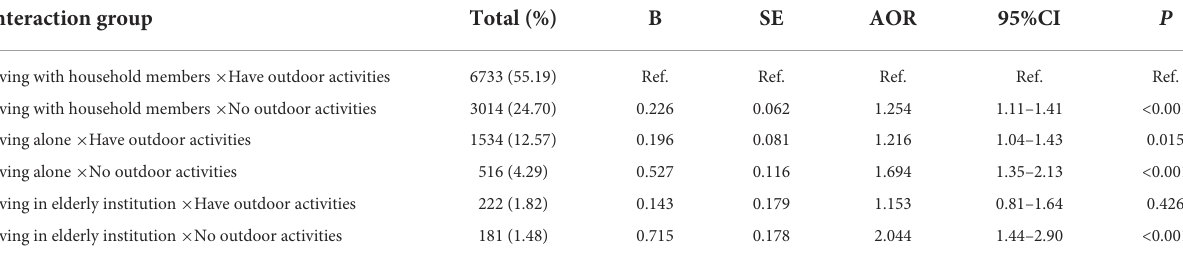
TABLE 3 Measuring the moderating effect of outdoor activities on living arrangements and depressive symptoms. Interaction